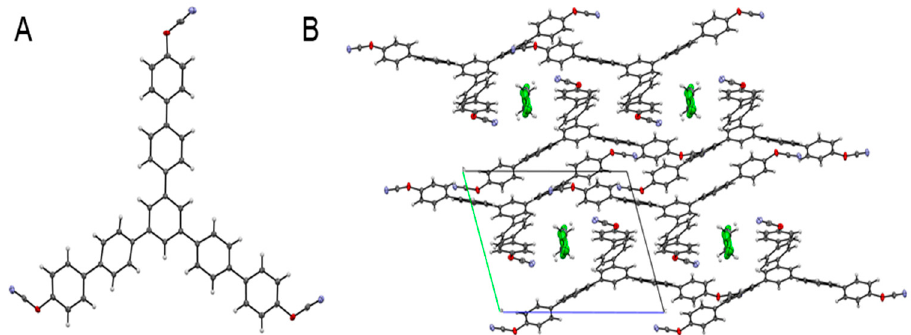
Figure 3. Single-crystal X-ray crystallographic structure of synthesized tricyanate ester 6 (H atoms— light grey, C atoms—dark grey, N atoms—blue, O atoms—red, Cl atoms—green) ( A ). Crystal packing of tricyanate ester 6 view along a axis ( B